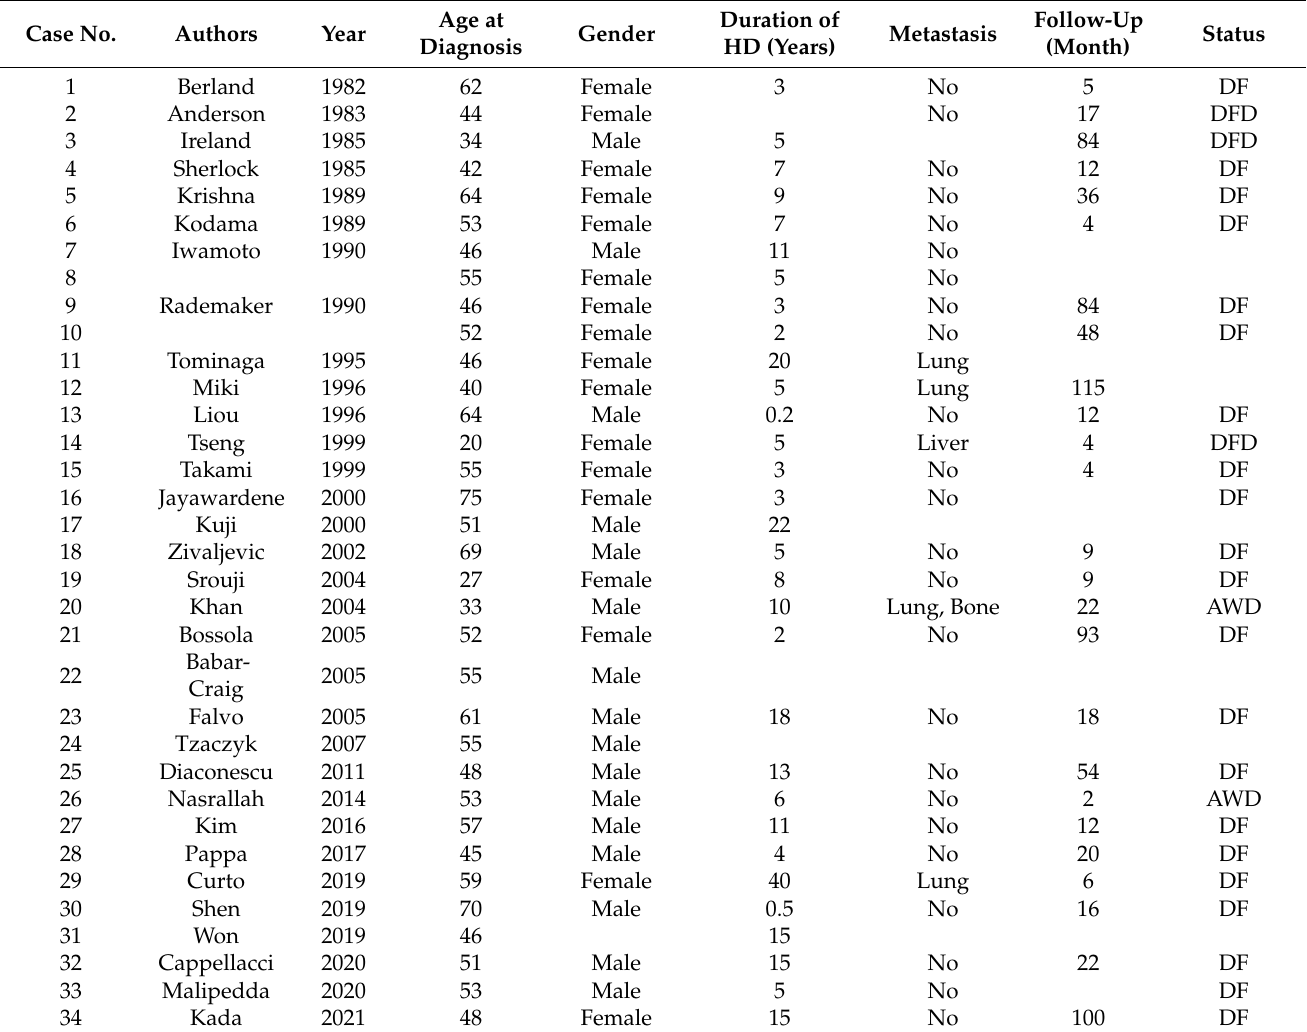
Table 1. Parathyroid Carcinoma in patients undergoing dialysis due to chronic renal failure reported in the literature